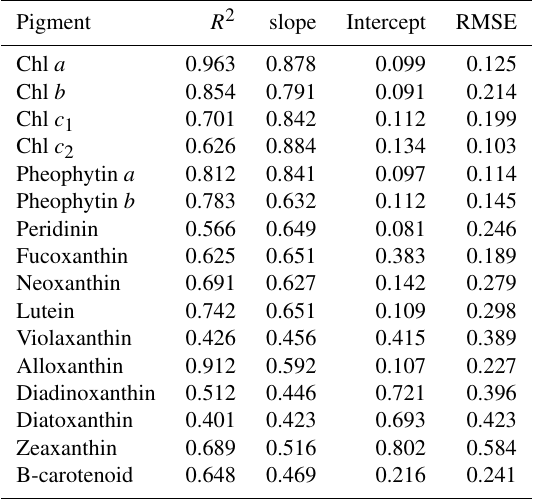
Table 4. Statistical results between HPLC-measured and NNLS- modeled